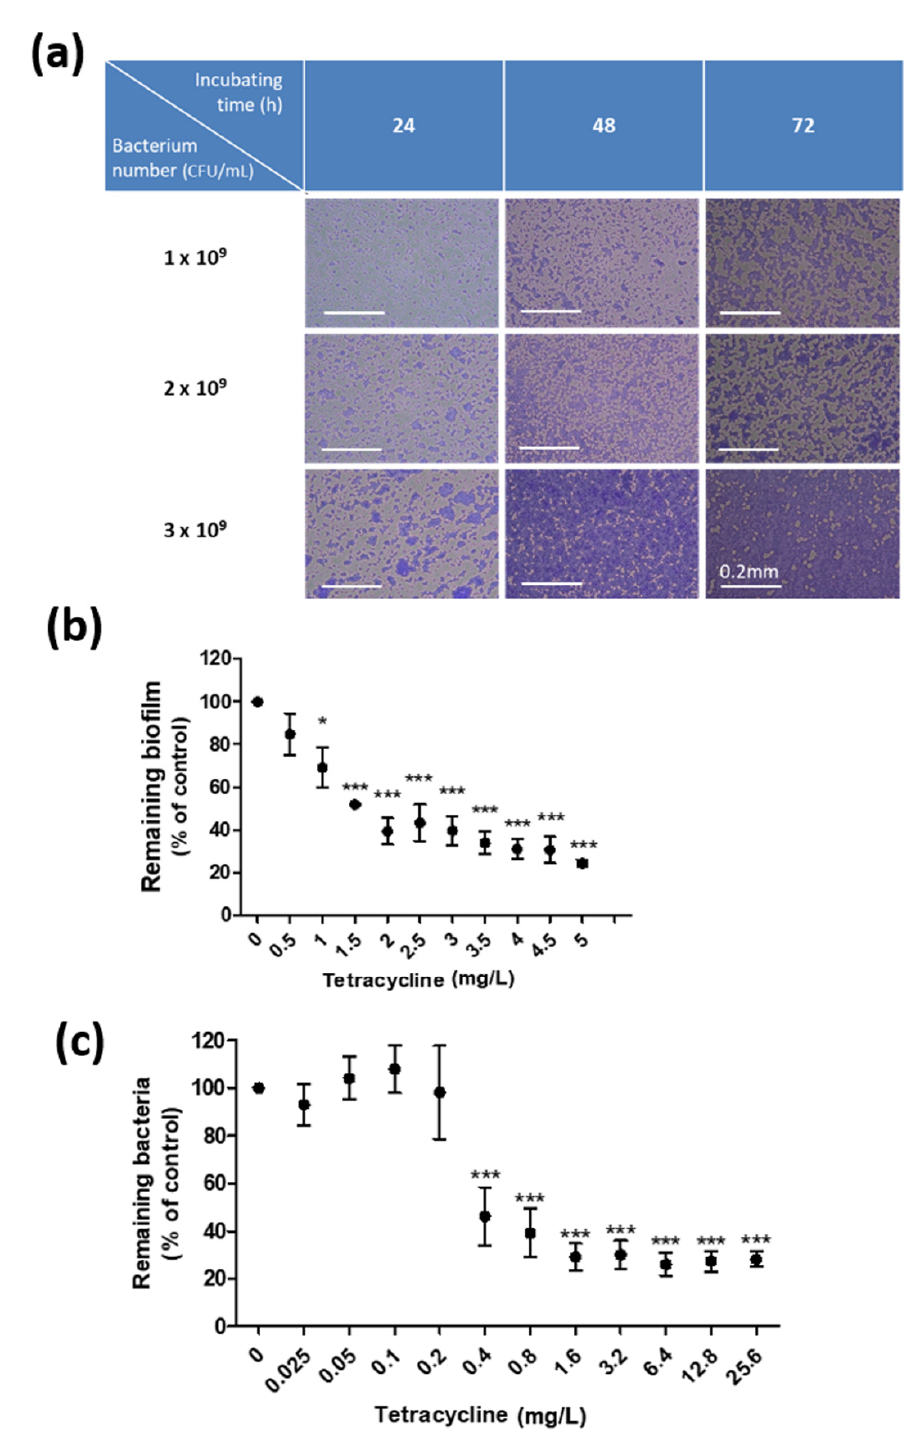
Figure 1. Development of an in vitro culture system for biofilms of Cutibacterium ( C. ) acnes . ( a ) Biofilms of C. acnes were cultured in vitro by incubating the bacterium with 0.5% dextrose glucose for 24–72 h. Original magnification, 200x. Scale bar = 0.2 mm. ( b ) The biofilm of C. acnes cultured in vitro was treated with tetracycline (TCN) at indicated dosages. The minimal dose of TCN that reduced the biofilm of C. acnes by 50% was 1.5 mg/L; n = 3 (mean ± SEM, * p < 0.05, *** p < 0.001). ( c ) A bacterial suspension of C. acnes was treated with TCN at the indicated dosages. The minimal dose of TCN that reduced a suspension of C. acnes by 50% was 0.4 mg/L; n = 3 (mean ± SEM, * p < 0.05, ** p < 0.01, *** p < 0.001).